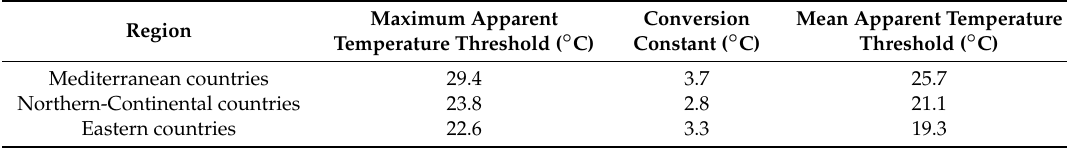
Table A1. Conversion terms and mean apparent temperature thresholds by European